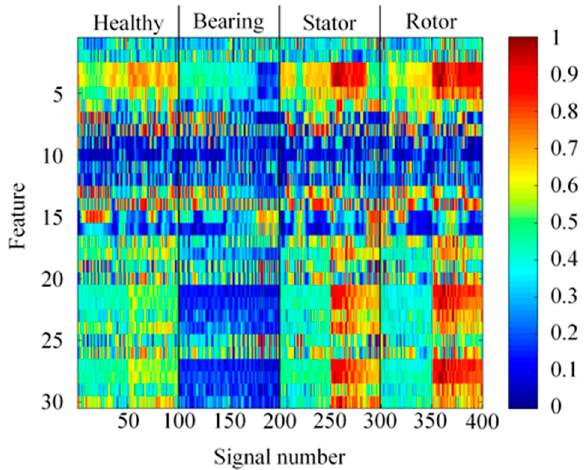
Figure 15. MRA feature energy diagram (SNR = 20 dB).